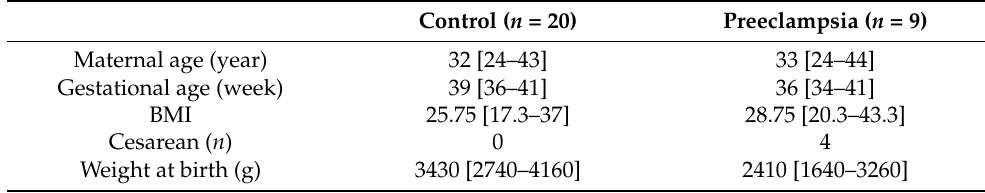
Table 4. Clinical characteristics of patients with preeclampsia and control